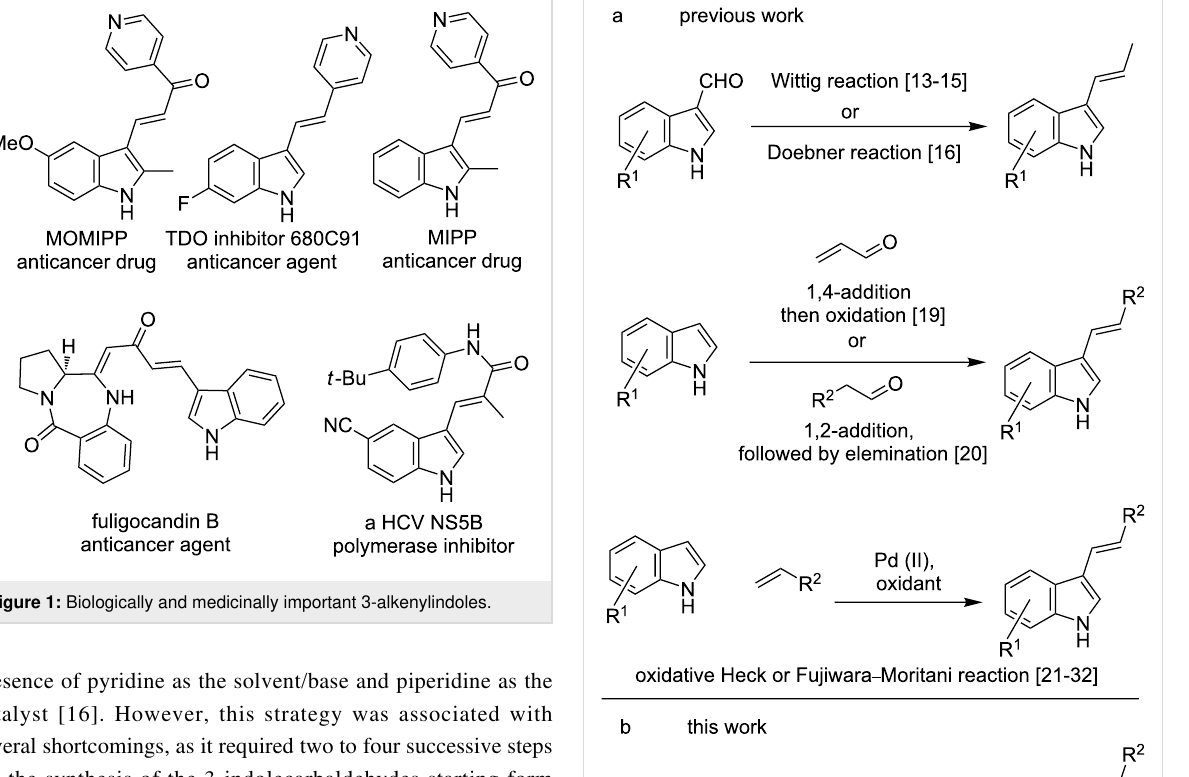
presence of pyridine as the solvent/base and piperidine as the catalyst [16]. However, this strategy was associated with several shortcomings, as it required two to four successive steps for the synthesis of the 3-indolecarbaldehydes starting form indoles, low yields, a narrow scope, and selectivity issues among the geometrical isomers, which led to troubles in purifi- cation [17,18]. As an example for the second category, Jiao and co-workers developed an organocatalytic C3–H alkenylation of indoles by the reaction of indoles with α , β -unsaturated alde- hydes in presence of morpholin-4-ium trifluoroacetate as a cata- lyst and a stoichiometric amount of DDQ to achieve oxidative dehydrogenation [19]. Recently, Maji and co-workers reported the synthesis of 3-alkenylindoles from indoles and α -hydrogen- containing alkyl-/arylaldehydes by successive Brønsted acid/ base catalysis (Scheme 1)